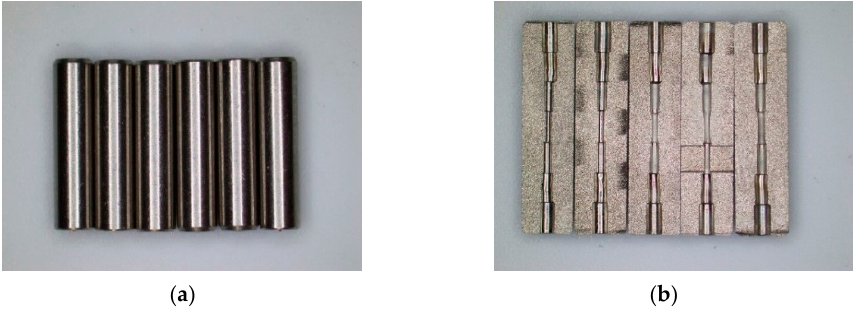
Figure 2. Sample diagram of the seven-order variable-diameter pipe. ( a ) Original sample; ( b ) The sample after wire cutting.